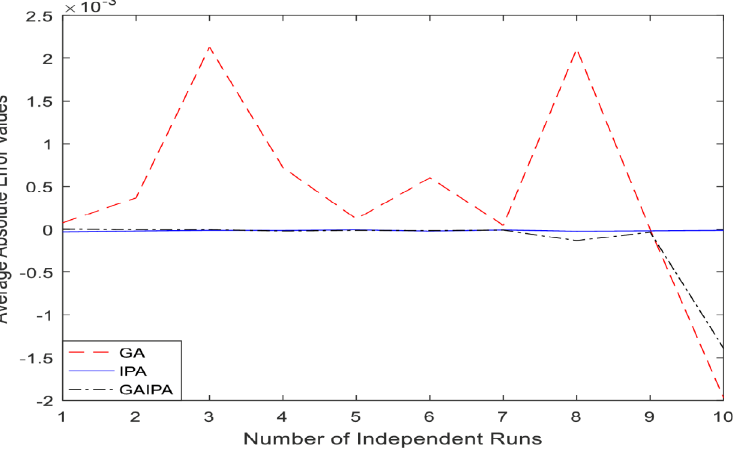
Fig 1. Graphical representation of average absolute errors for Example #01 when δ = 0.6 using Log Sigmoid.